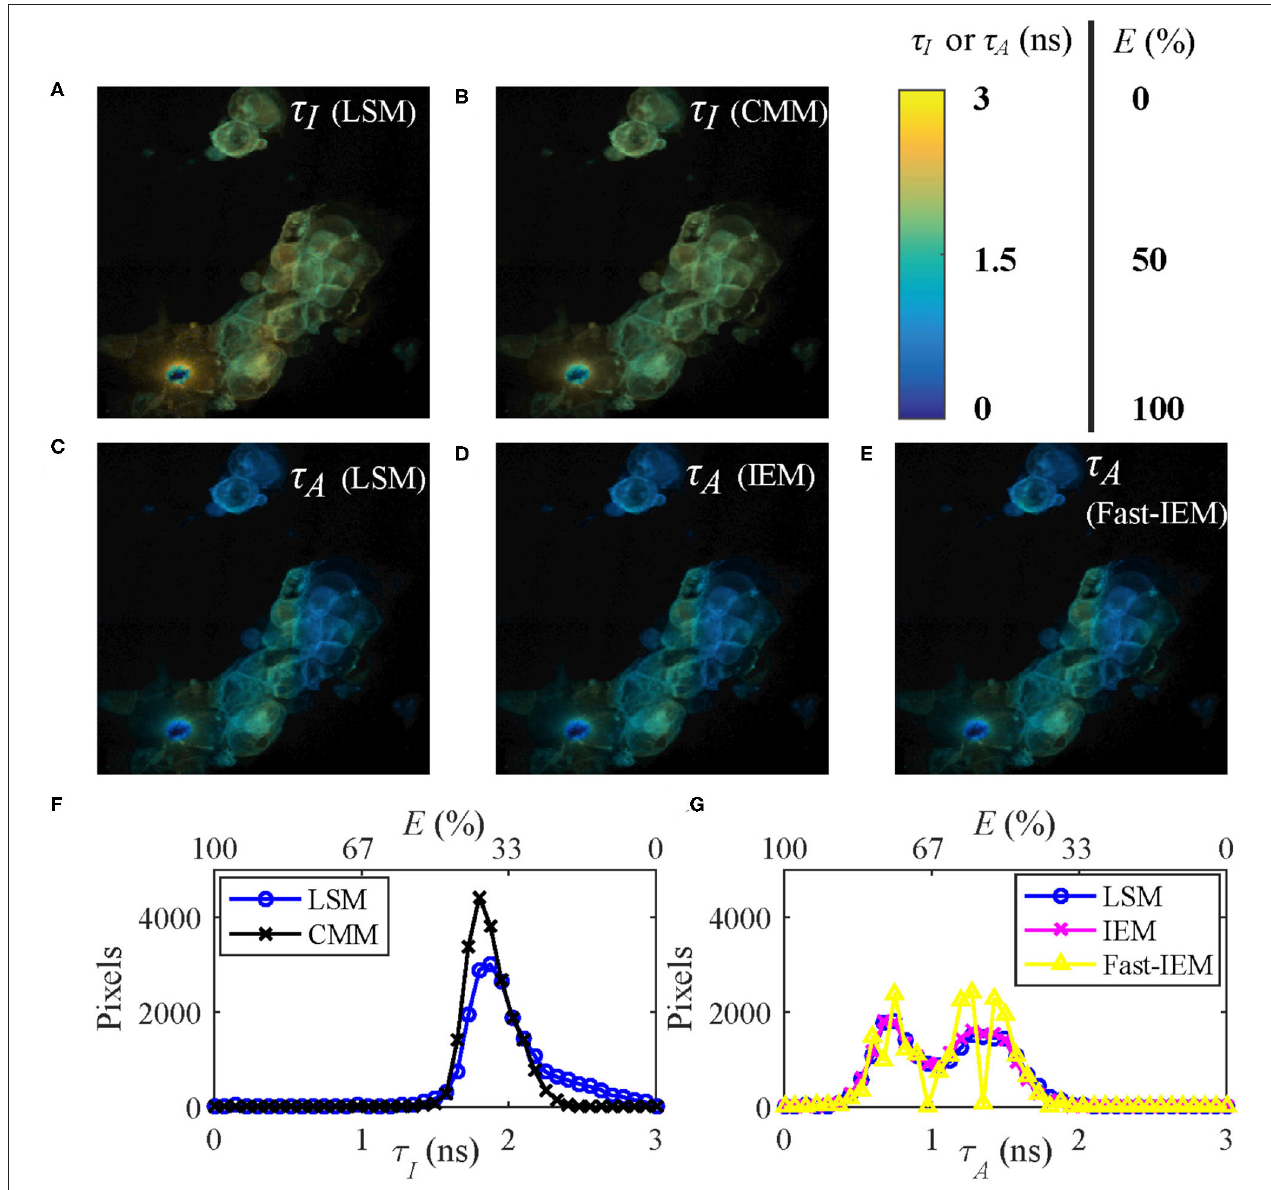
FIGURE 7 | (A,C) τ I and τ A images evaluated with LSM-2, (B,D) τ I and τ A images evaluated with CMM and IEM, respectively. (E) τ A image with Fast-IEM. (F) Histograms of τ I with LSM-2 (blue) and CMM (black). (G) Histograms of τ A with LSM-2 (blue), IEM (magenta), and Fast-IEM (yellow). The color bar represents lifetimes and the pixel brightness represents photon counts. (A–E) Can also represent FRET efficiency ( E ) images evaluated with the corresponding lifetime images with the color bar representing the range of E , 0 100%. (F,G) Can also be used to show the histograms of E with the upper x ∼